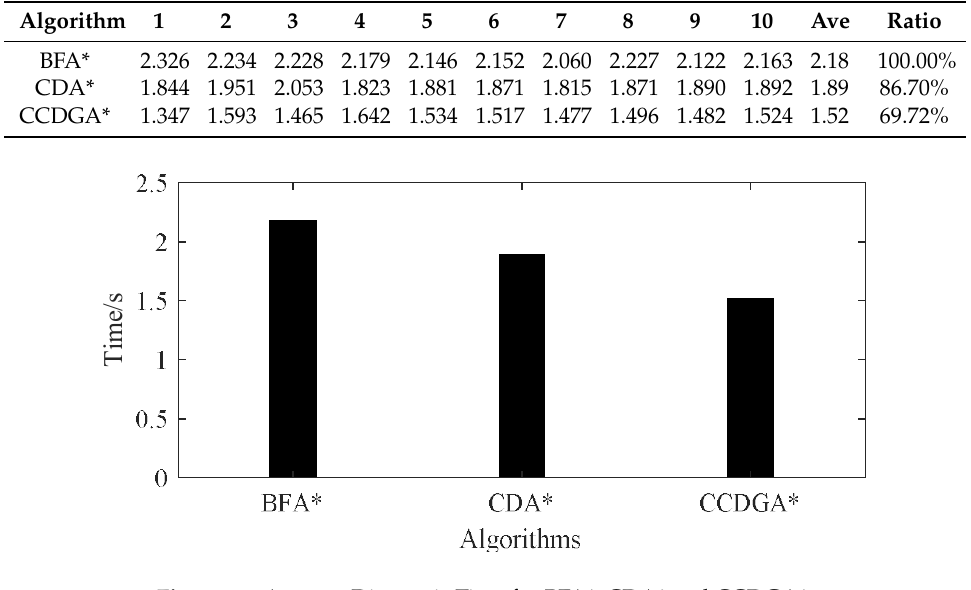
Table 7. 3-Diagnosis Time(s) for BFA*, CDA* and CCDGA*.